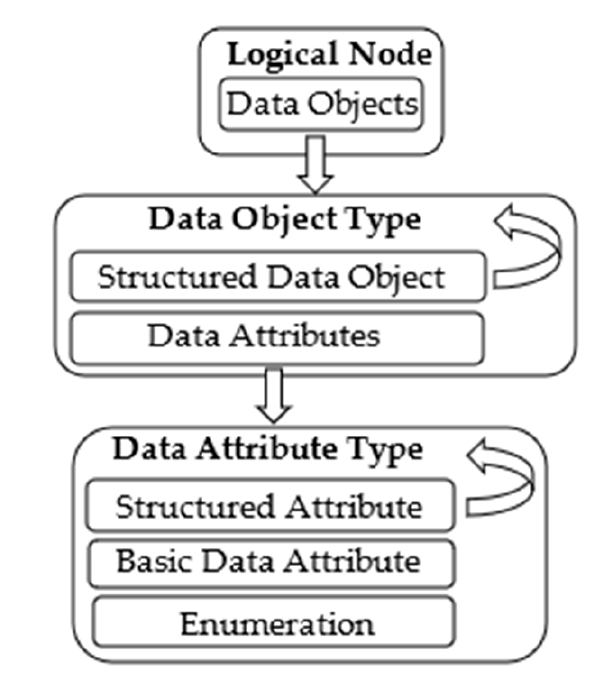
Figure 2. IEC 61850 data type template hierarchy.